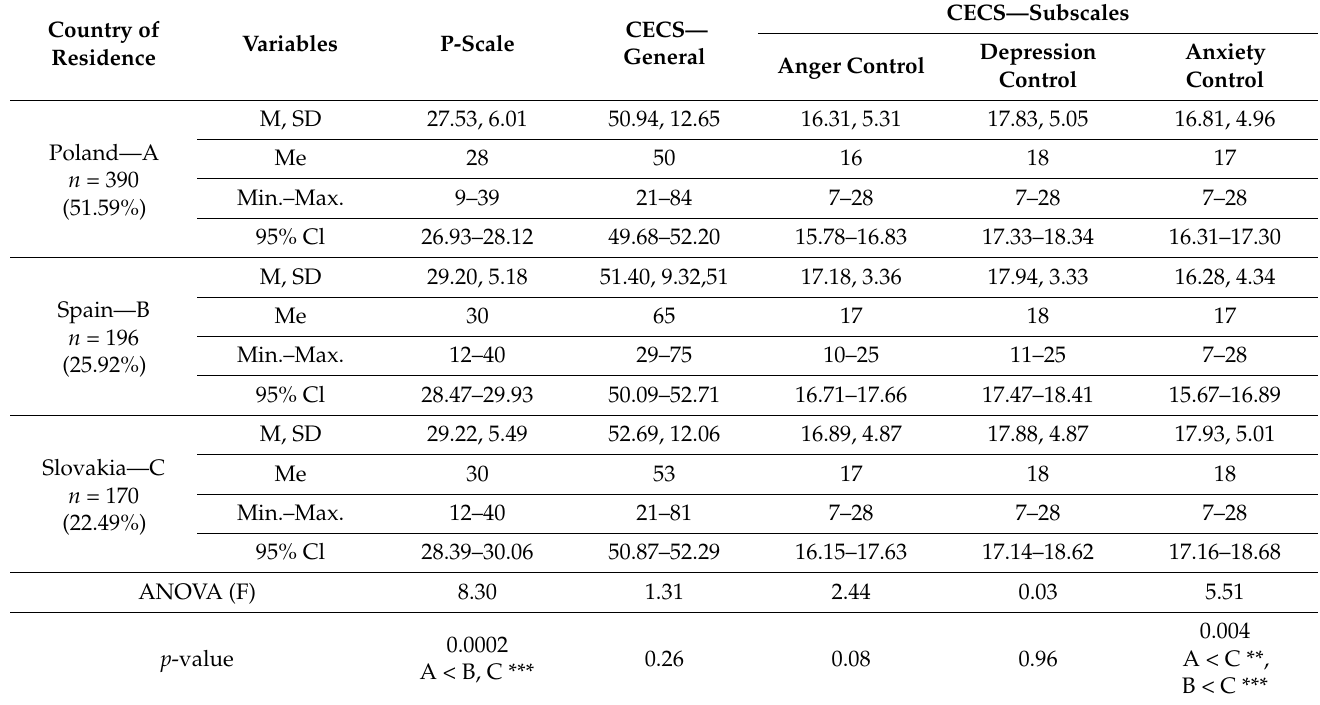
Table 2. Diversity of results for positive orientation and emotional control in students in the Polish, Spanish and Slovak